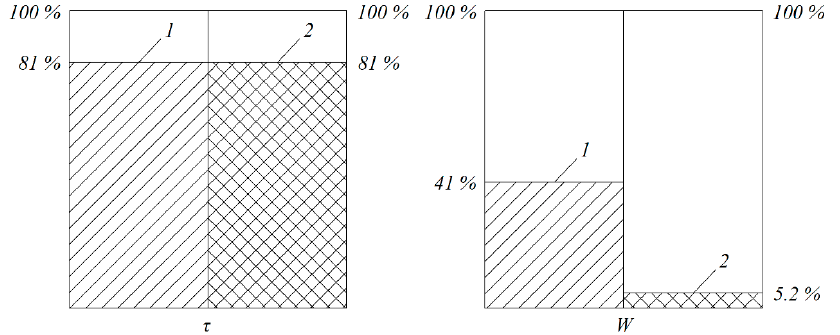
Figure 2. The relative duration ( τ ) and energy intensity ( W ) of heating and high-temperature holding in the thermal cycle of the manufacture of aluminum oxide ceramics without additives of other metal oxides (100%) and with two percent additives of titanium and manganese dioxides in equivalent (1) and real (2) conditions of experimental laboratory production.